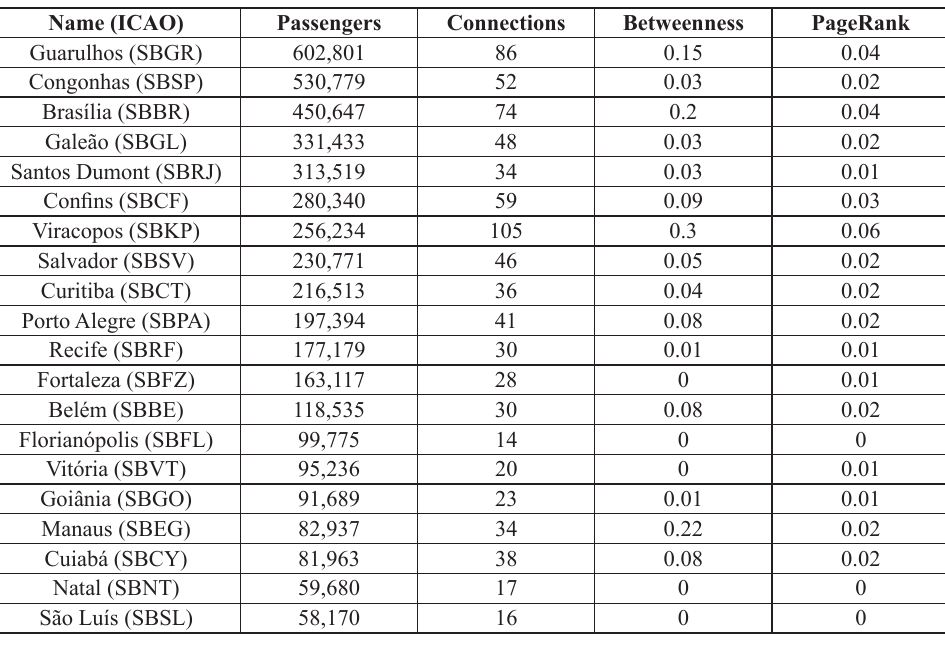
Top-20 Airports - Maximum Number of Passengers - National Flights.